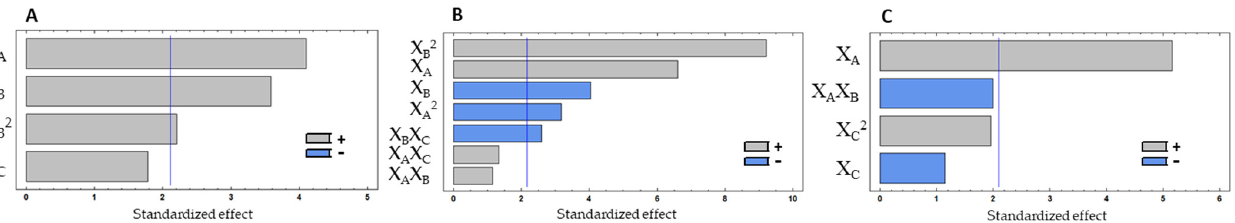
Figure 3. Pareto charts with the effect of three experimental factors, in decreasing order, obtained for protein % ( A ), antioxidant ( B ) and anti-hypertensive ( C ) properties in the experimental design with corolase, showing the most influent factors. The vertical lines in the pareto charts represent the level of significance ( p = 0.05). X A —Enzyme %; X B —Hydrolysis temperature; X C —Hydrolysis time.